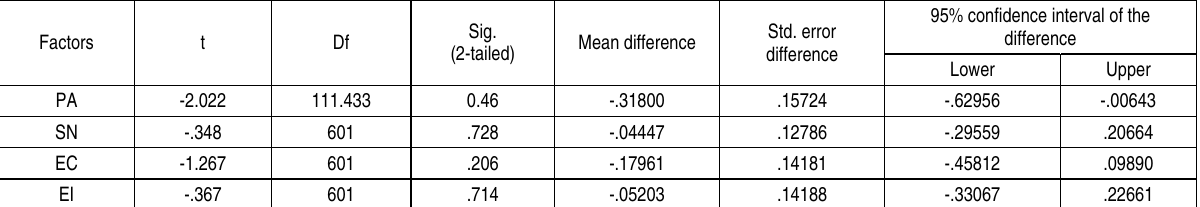
Table 4. Difference in means of factors of entrepreneurial and non-entrepreneurial